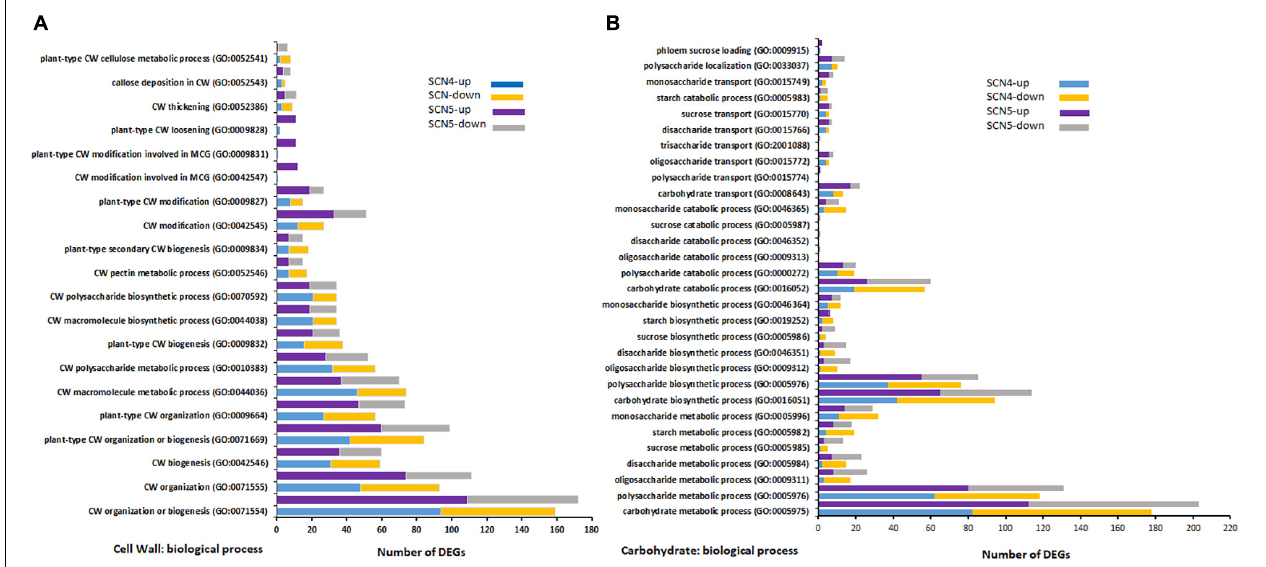
FIGURE 5 | Top GO-enriched differentially expressed up-/down-regulated genes (DEGs) associated with cell wall (CW) modification (A) and carbohydrate biological process (B) on soybean breeding line 09-138 infected by SCN4 (soybean cyst nematode race 4) and SCN5 when compared with the control. The x -axis displays DEG number, and the y -axis represents the GO pathway.